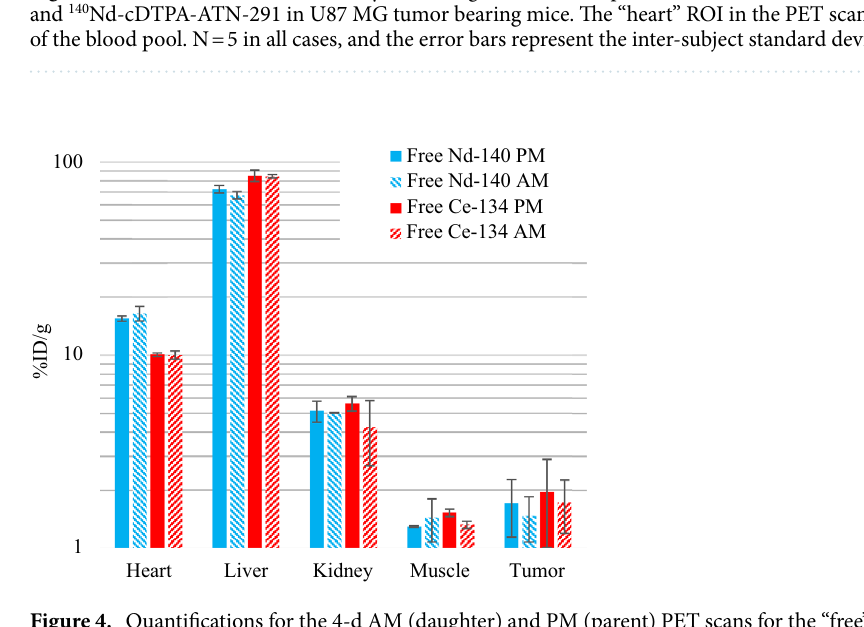
Figure 4. Quantifications for the 4-d AM (daughter) and PM (parent) PET scans for the “free” radionuclides: 134 Ce and 140 Nd chlorides formulated in HEPES buffered saline, in U87 MG tumor bearing mice. Data are plotted on a log scale. Note: The “heart” ROI in PET is representative of the blood pool N = 2 in all cases, and the error bars represent the inter-subject standard